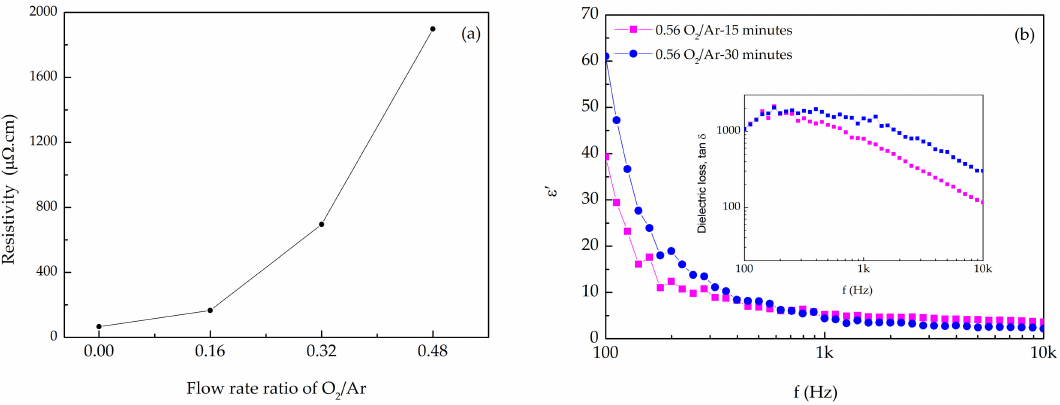
Figure 10. ( a ) Electrical resistivity of MoO x thin films at different O 2 /Ar flow rate ratio; ( b ) Dielectric constant and loss of the samples 0.56 O 2 /Ar-30 min and 0.56 O 2 /A-15